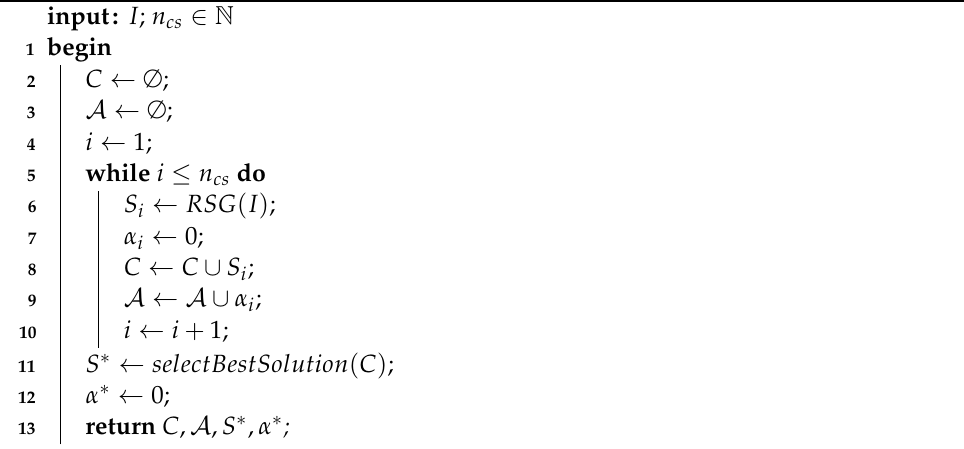
Algorithm 2: initializationP (Initialization Phase of the CARP-ABC